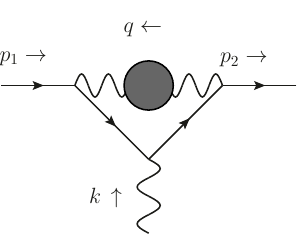
Figure 3. The leading contribution of the hadronic vacuum polarization to the QED